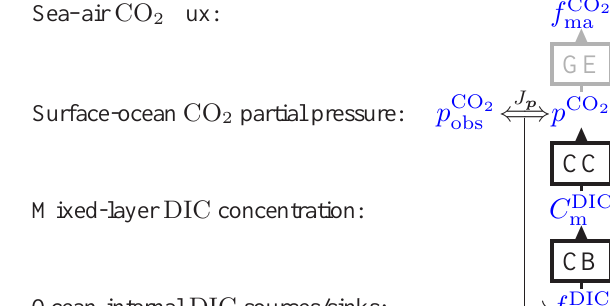
Fig. 3. Top: Globally integrated sea–air CO 2 exchange estimated from SOCAT data (run SFC , blue). Negative values indicate an ocean CO 2 sink. Bottom: Interannual anomalies of the globally integrated sea–air CO 2 exchange. The time series have been desea- sonalized and filtered for interannual variations, and the 1993–2008 mean flux has been subtracted (positive values indicate an increased ocean CO 2 source or a decreased sink). The light-grey band around the standard case comprises a set of sensitivity cases (Sect. 2.3.4). The time period shown excludes the first year for spin-up, and the years after the end of SOCAT v2 (end of 2011).